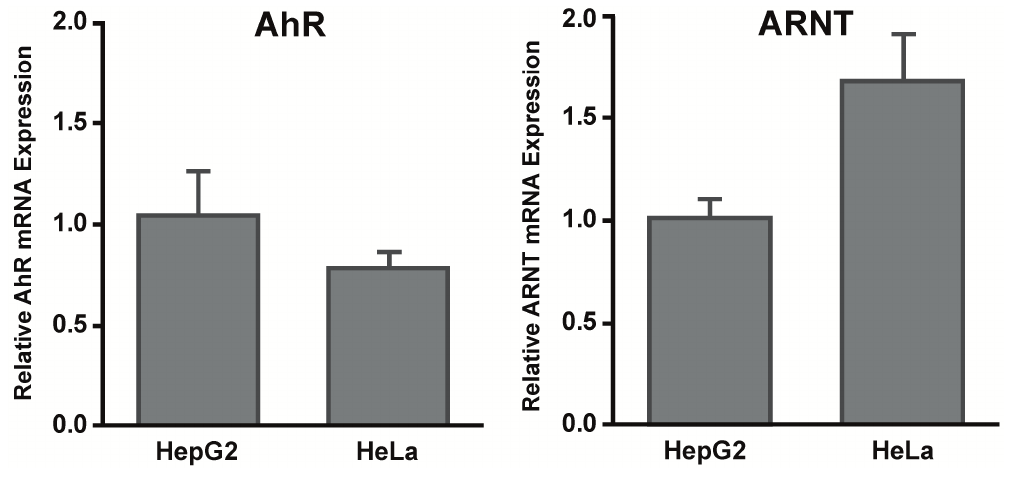
Figure 7. Relative aryl hydrocarbon receptor (AhR) and aryl hydrocarbon receptor nuclear translocator (ARNT) mRNA levels in HepG2 and HeLa cells. Basal AhR and ARNT mRNA expression levels were measured in untreated HepG2 and HeLa cells using qRT-PCR. Analysis was performed with normalization to RPLP0. Error bars = SEM; n =